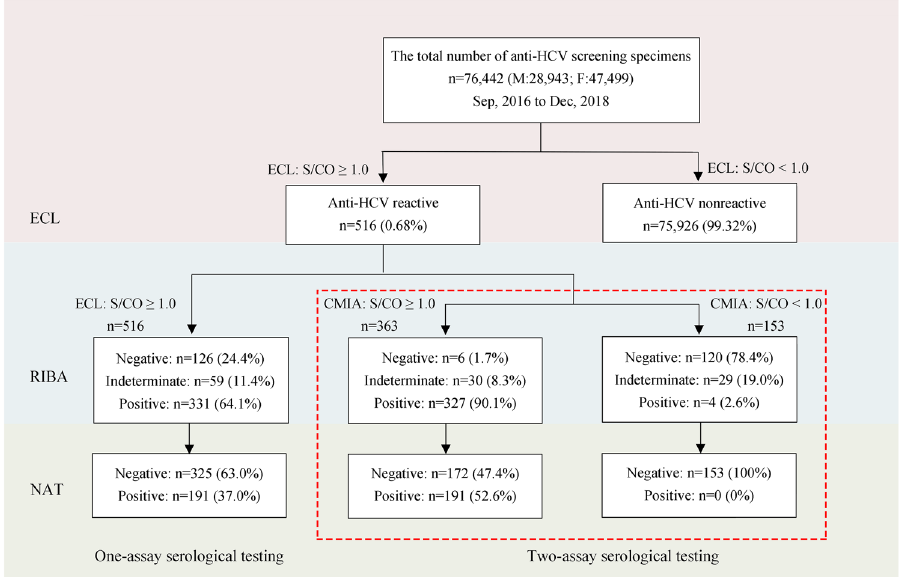
Figure 1. Schematic illustration of the HCV testing sequence for one- or two-assay serological testing strategies (ECL screening and CMIA